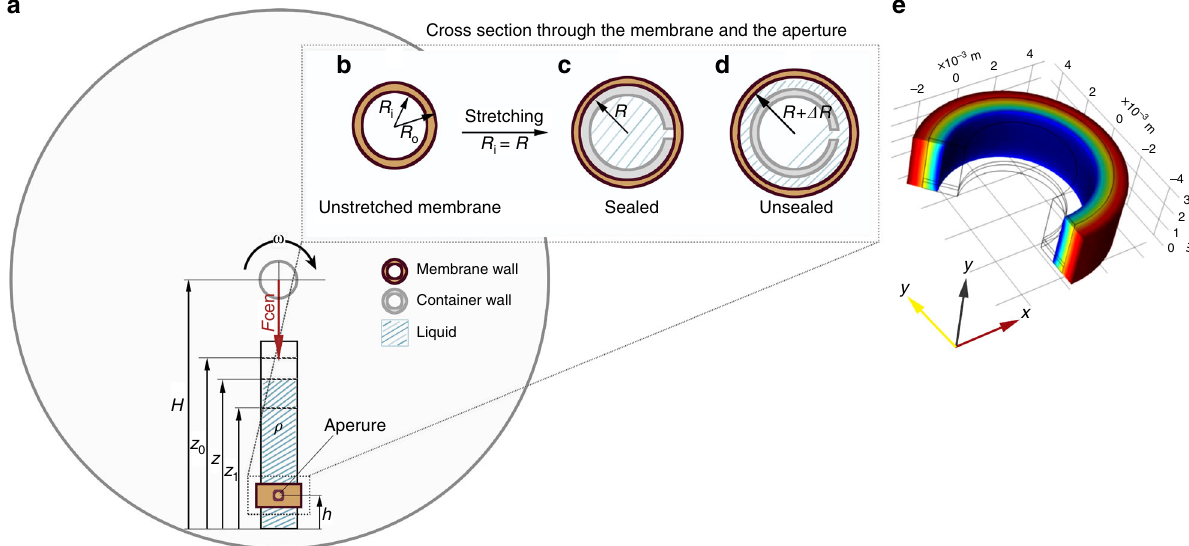
Fig. 8 The analytical treatment of the micro-dispenser actuated by centrifugation. a Schematic of the micro-dispenser inserted in a rotating frame together with its actuation mechanism. The inset shows a section through the membrane and the tube. b The membrane un-stretched. c A tube (of outer radius R ) is sheathed in the stretched membrane, providing a hermetic sealing. d At given speed, the membrane is stretched to inner radius R i > R , and liquid is released. e Example results from simulations, showing deformed membrane and color-coded radial pressure for an opening membrane of R i = 4.8 mm, t = 1.6 mm on a tube with R = 3.3 mm, Case